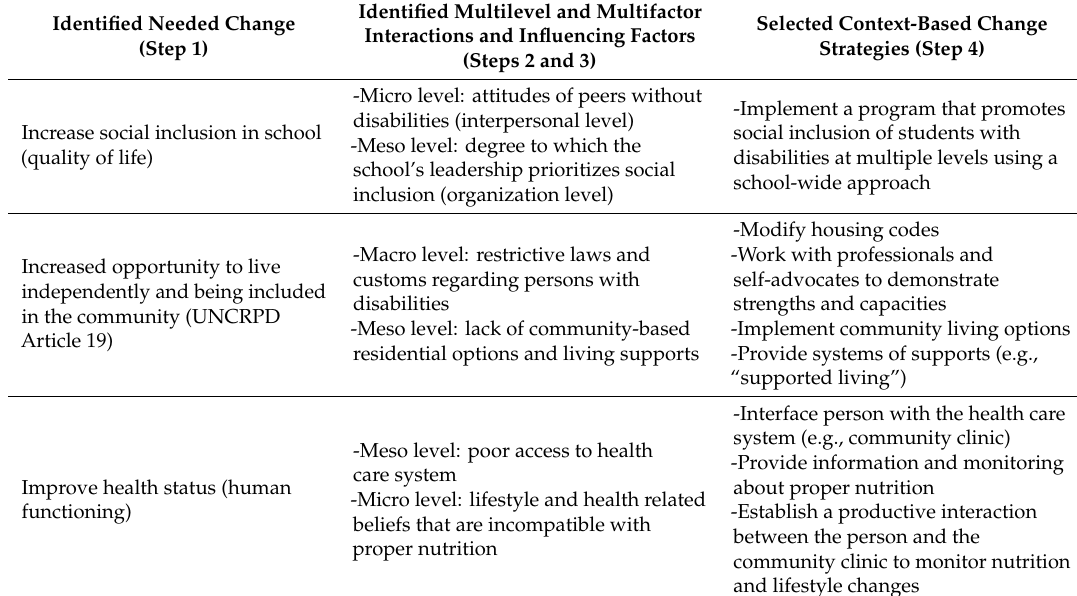
Table 2. The four-step approach to bring about